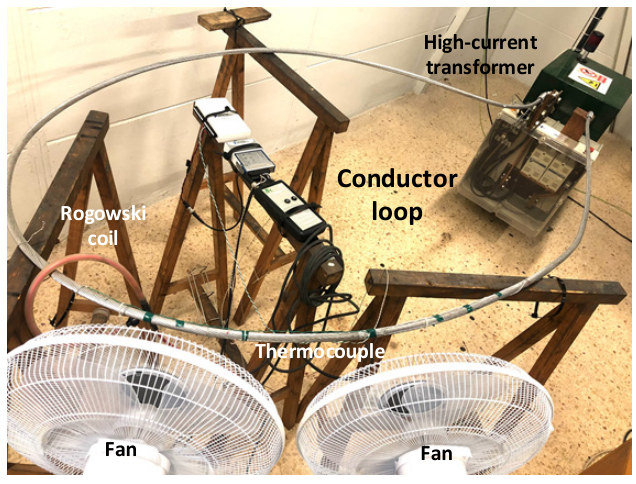
Figure 3. Experimental loop for testing the different ACSR conductors.